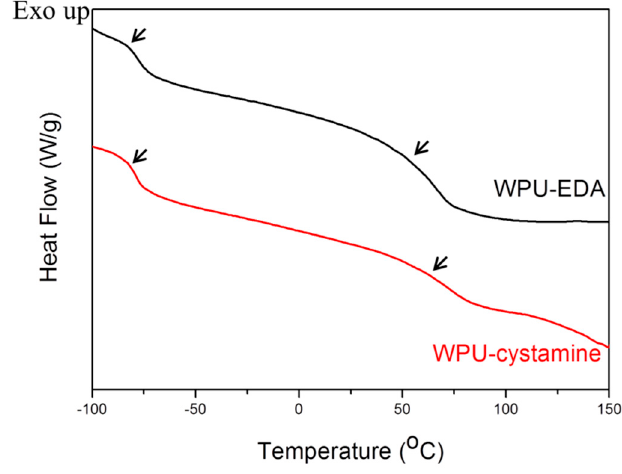
Figure 3. Mechanical properties of WPU-EDA and WPU-cystamine.